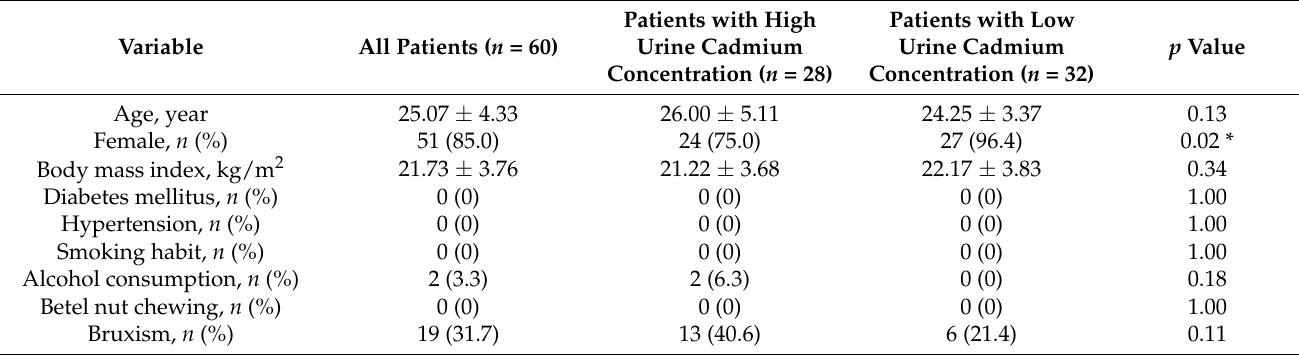
Table 1. Baseline demographics of orthodontic patients stratified according to their urine cadmium concentrations as high or low ( n =